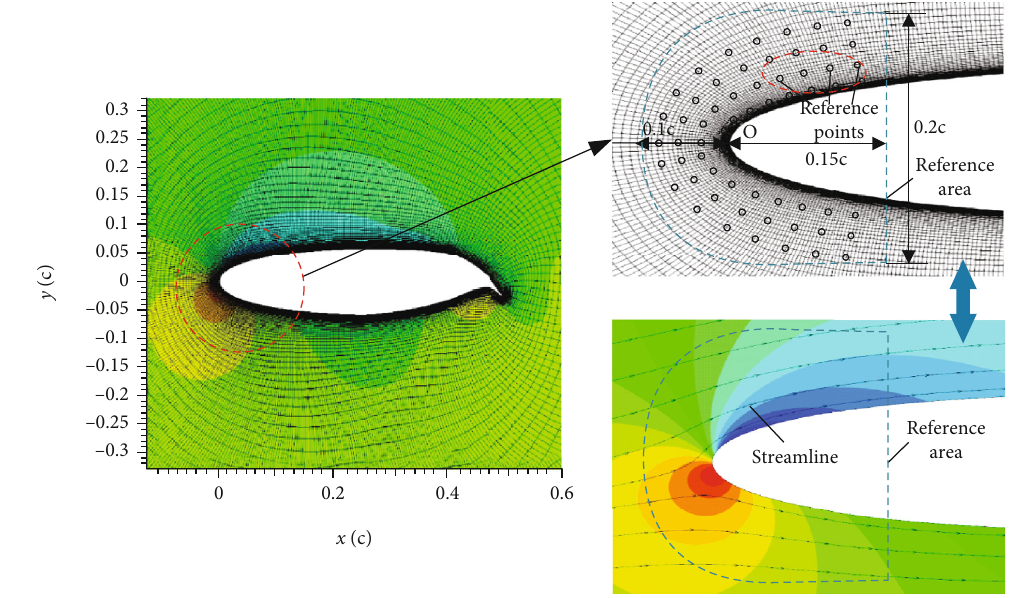
Figure 4: Reference area for hybrid airfoil design.